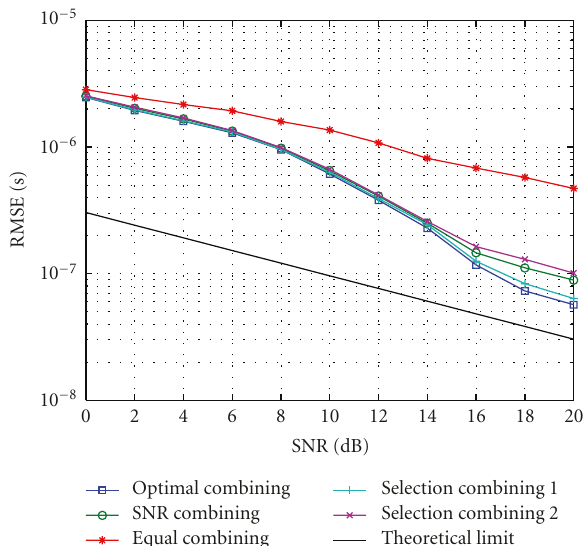
Figure 6: RMSE versus SNR for the proposed algorithms, and the theoretical limit (CRLB). The signal occupies two dispersed bands with equal bandwidths of 400 kHz.